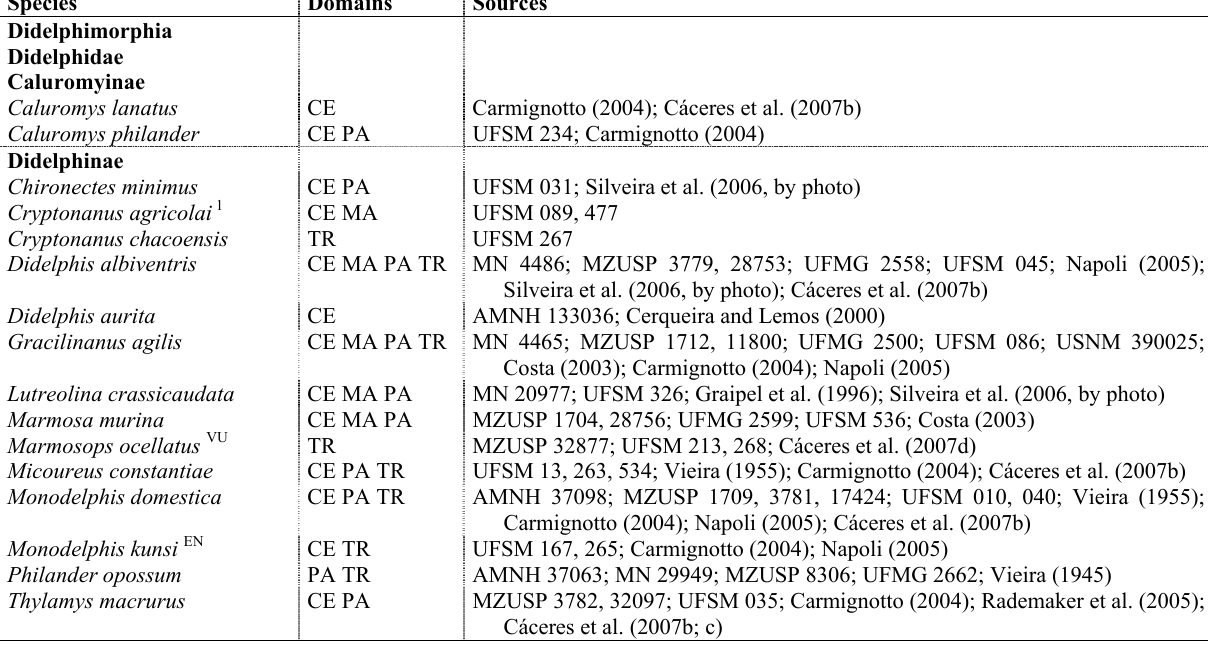
Table 1 . Mammals recorded in the state of Mato Grosso do Sul, south-western Brazil, according to zoological collections, literature, or photographic records. Domains: CE, Cerrado; MA, Atlantic Forest; PA, Pantanal; TR, Transitional zone between Chaco and Dry Amazon Forests. Zoological collections follow acronyms cited in the text (Data collection). Asterisks indicate threatened species according to IBAMA (2003). IUCN threaten category (EN, endangered and VU, vulnerable) was supplied when there was no threaten indication by IBAMA. When record was by photo, this is pointed out in the column